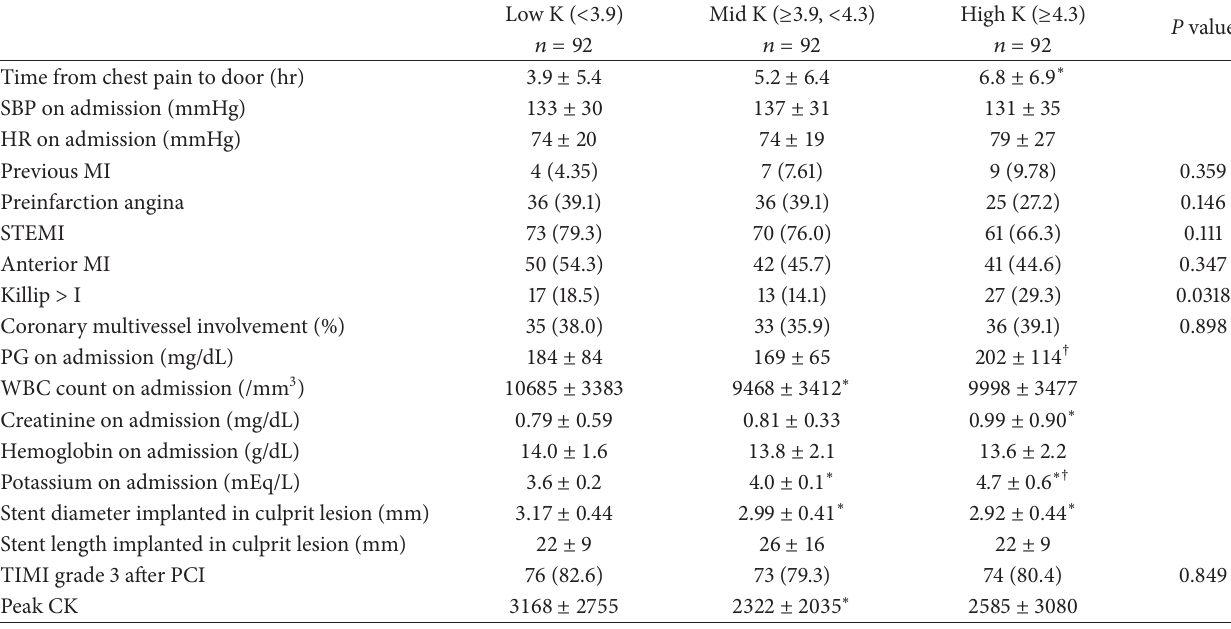
Table 2: Clinical and angiographic characteristics of acute myocardial